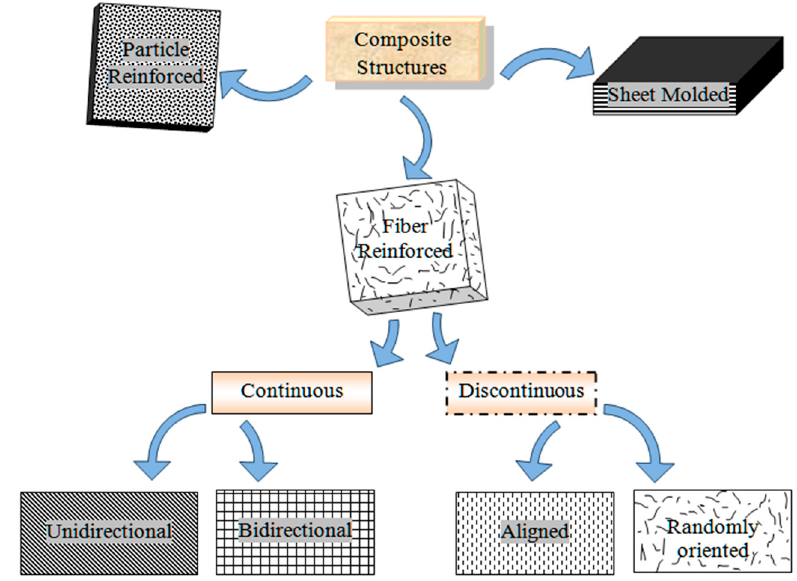
Figure 1. Classification of composites.